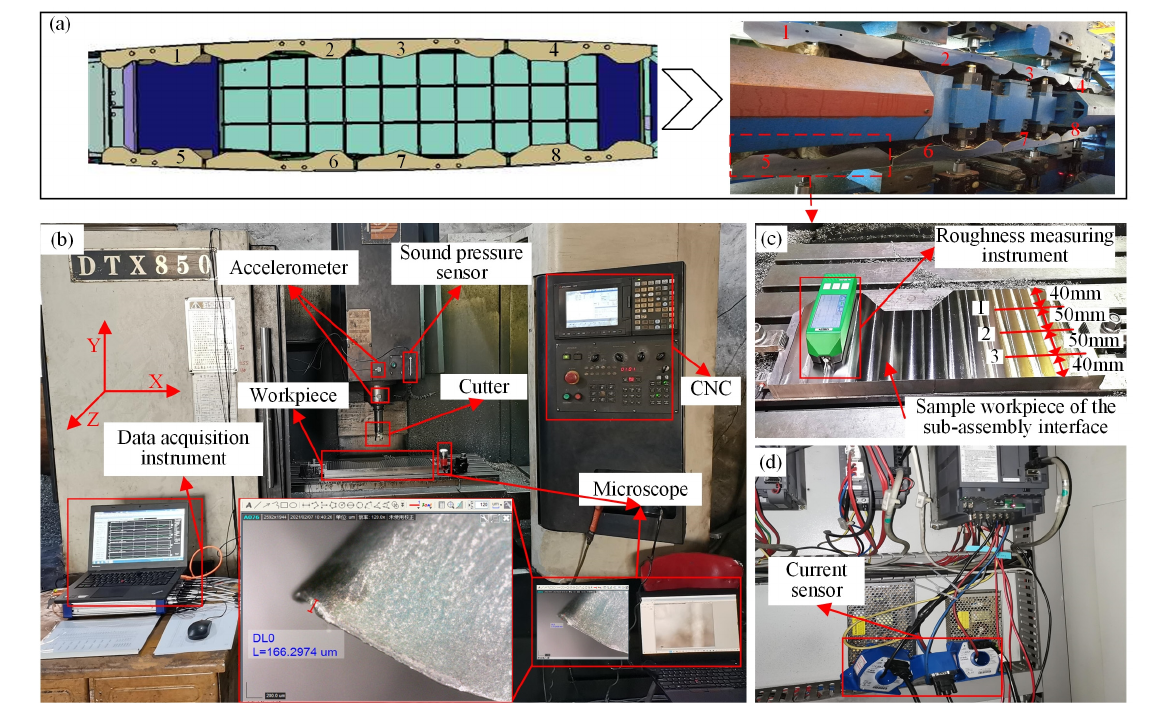
Figure 10. Experimental setup: ( a ) Assembly interfaces; ( b ) machining site; ( c ) sample workpiece; ( d ) spindle controller.